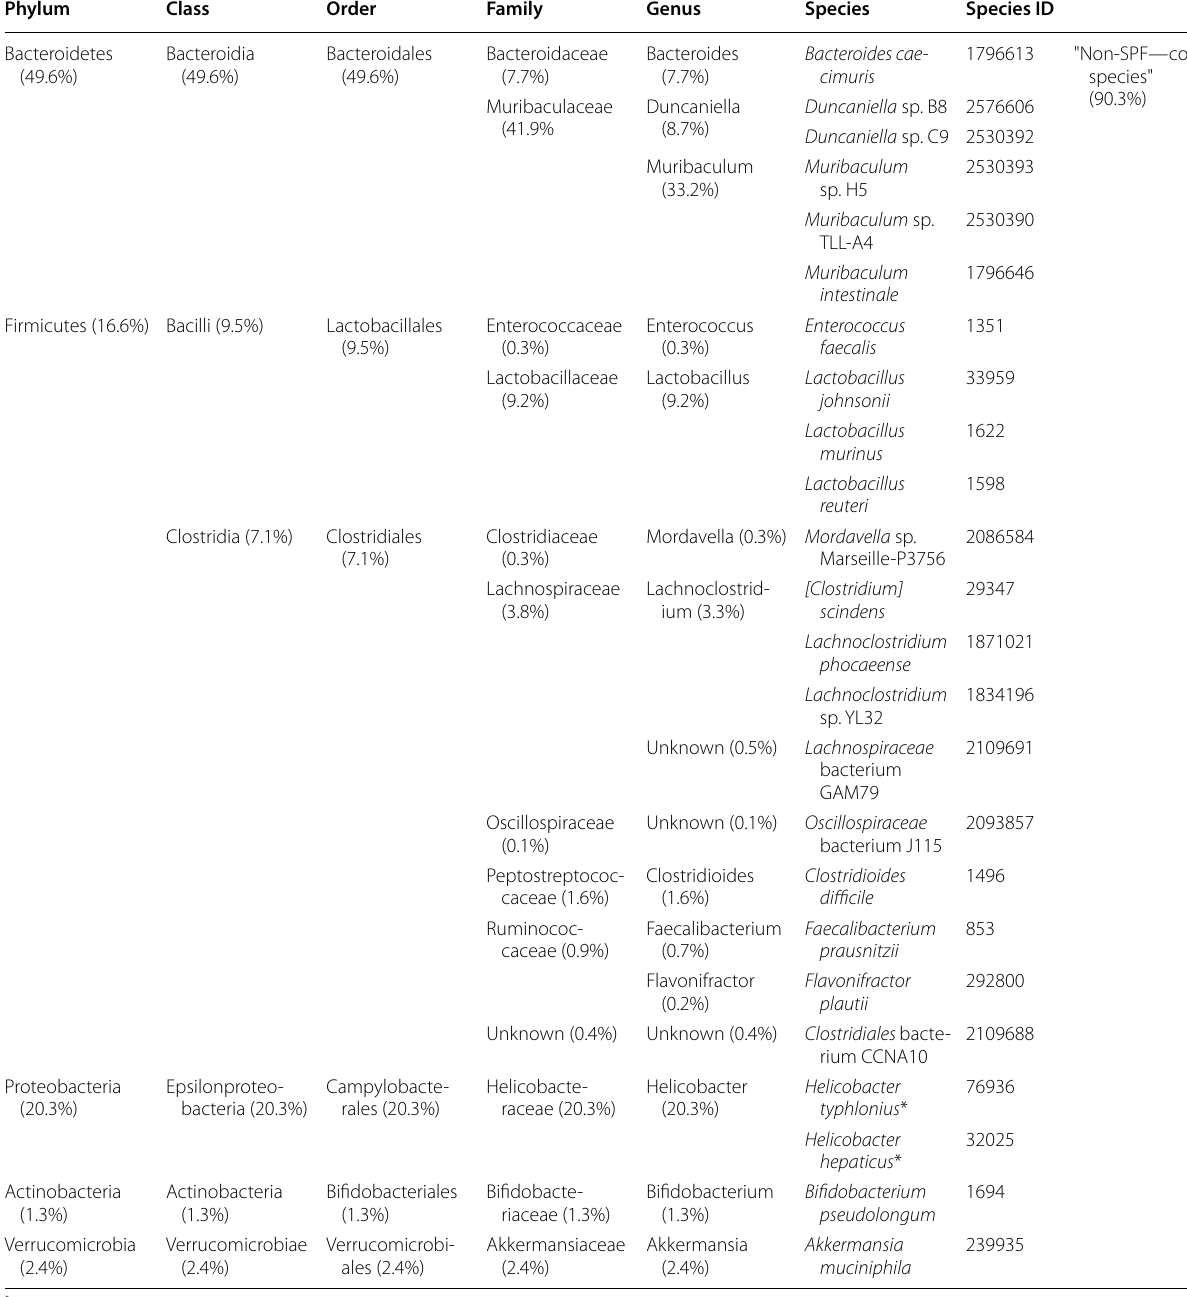
Table 2 Main species constituting the microbiota in non-SPF